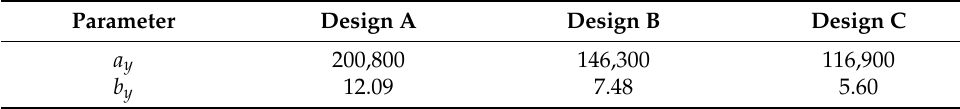
Table 7. Parameter values of guidance stiffness.